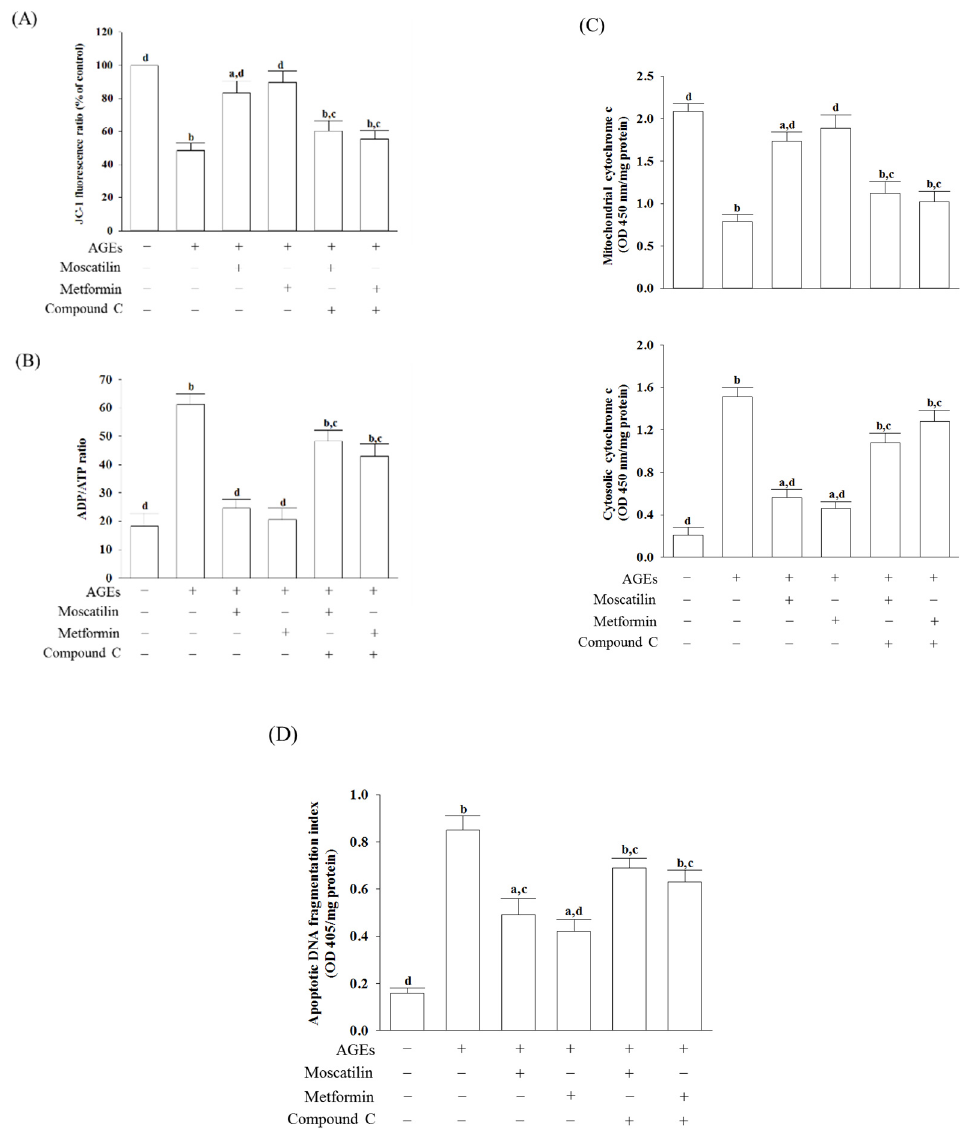
Figure 3. Influences on mitochondrial functions in AGEs-treated SH-SY5Y cells. Cells were